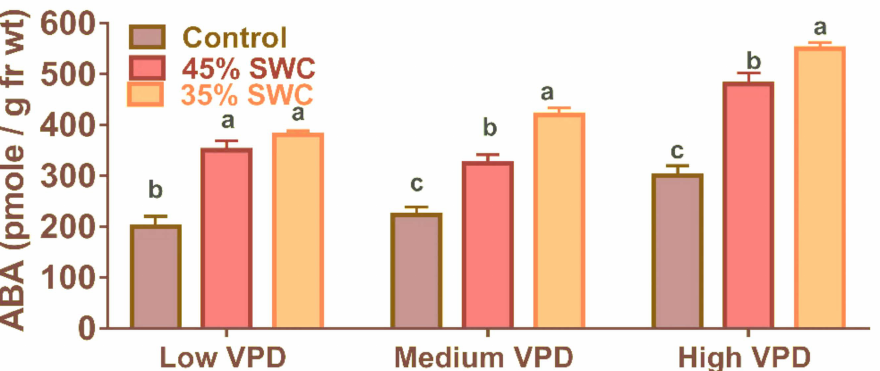
Figure 4. Foliar abscisic acid (ABA) (Pico mole/g fresh weight) concentration of maize subjected to three water treatment levels under three different vapor pressure deficit (VPD) levels. The bars (Average ± S.E.) represented by similar alphabet were not significantly different calculated based on Tukeys-Kramer method at p <